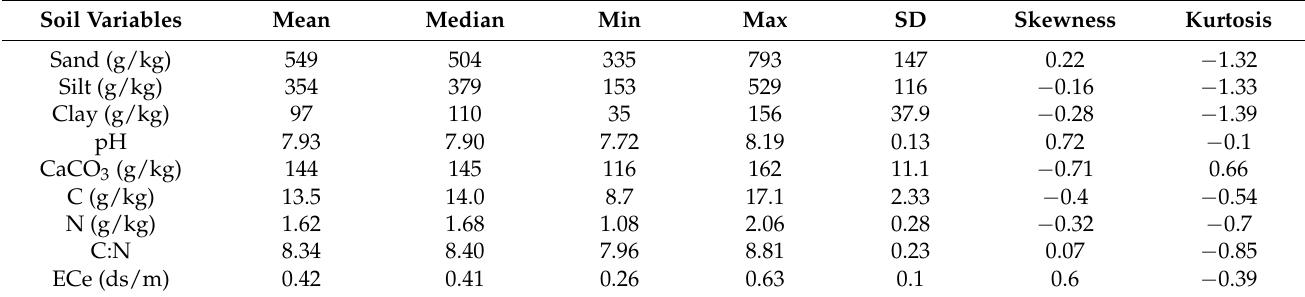
Table 7. Table 6. Descriptive statistics of soil traits (depth 0–0.6 m).